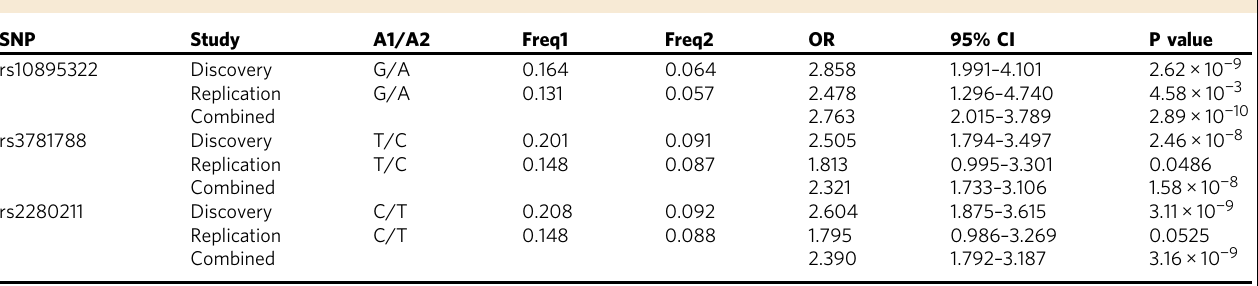
Table 1 Association results for the top three genotyped SNPs at